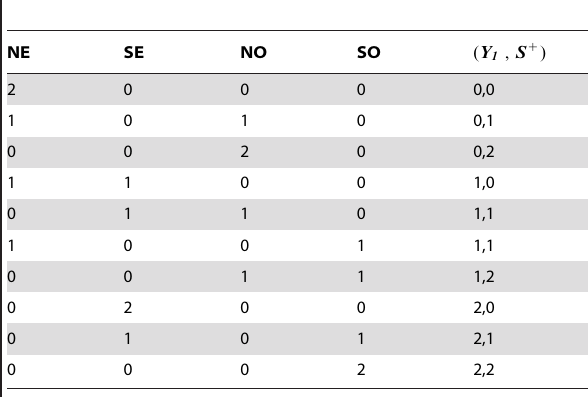
Table 4. Enumeration of States and Signals with 2